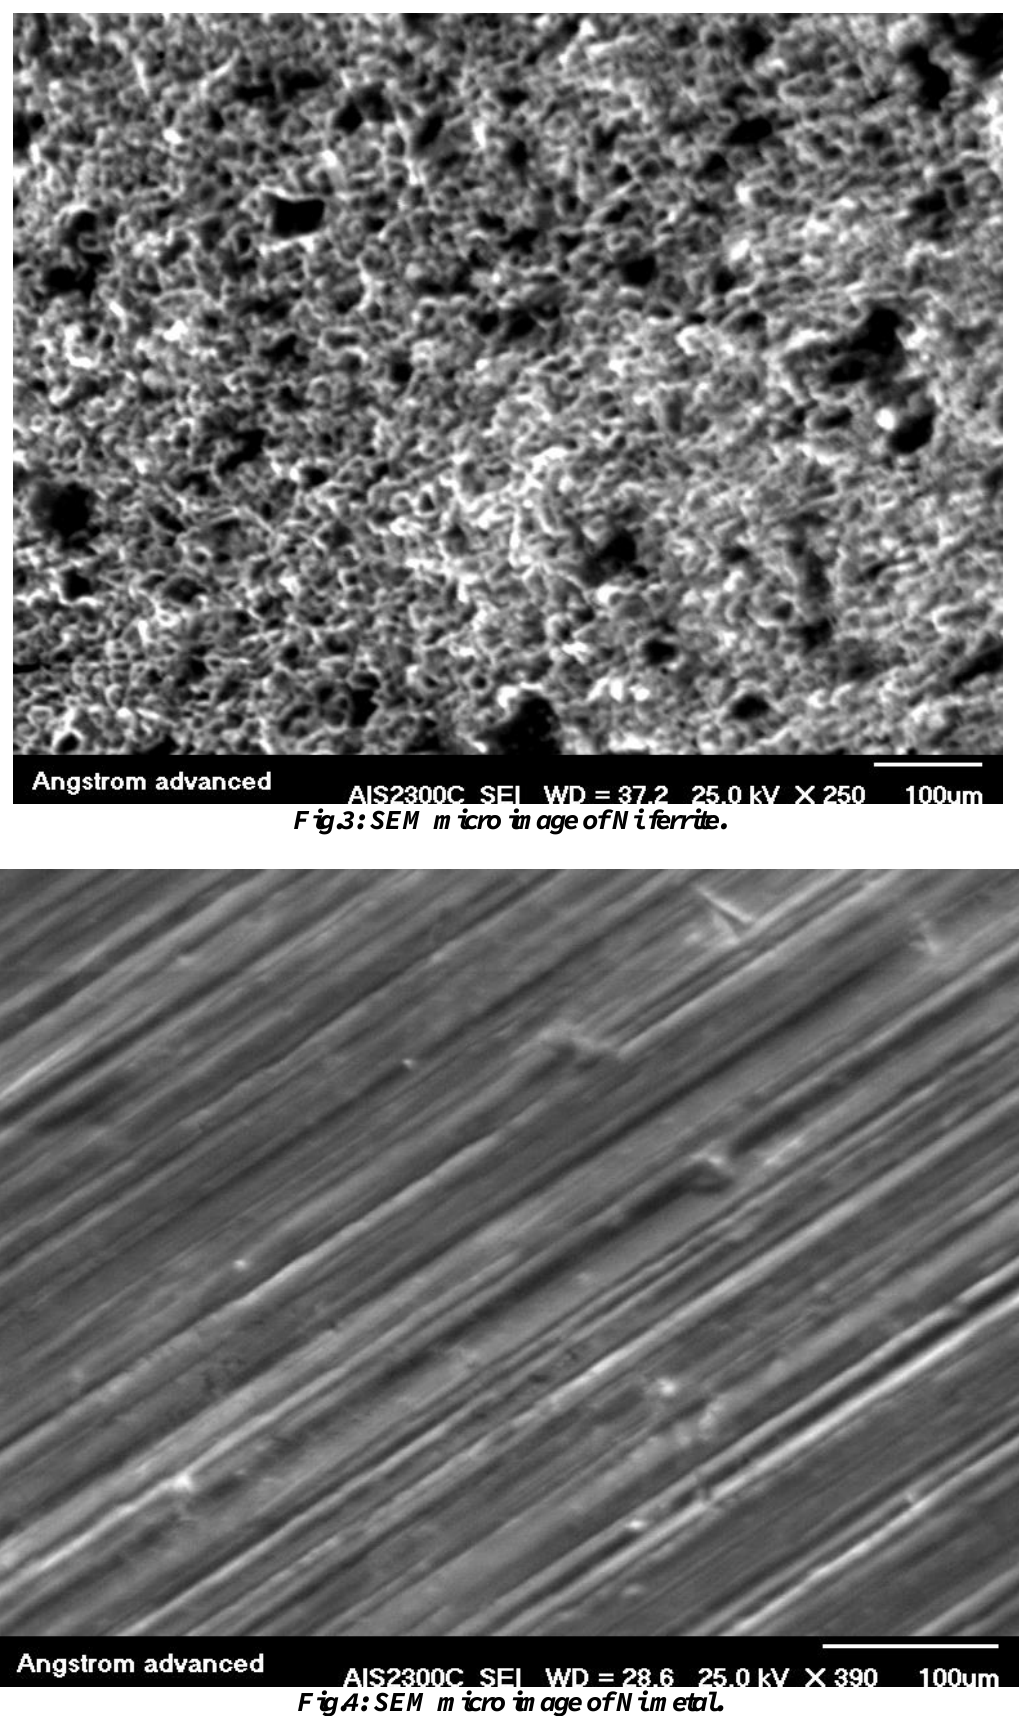
Fig.4: SEM micro image of Ni